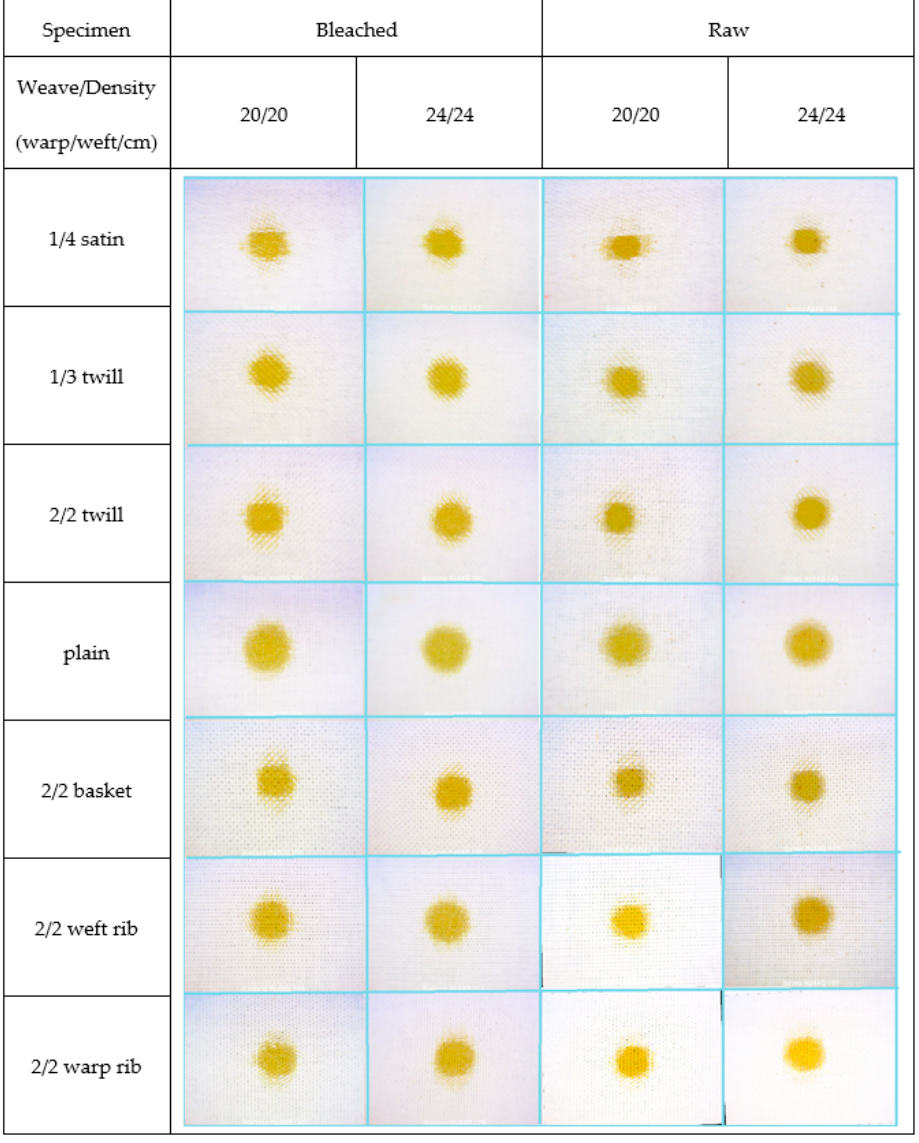
Figure 8. Images of raw and bleached specimens at the end of spreading of pumpkin oil droplets. The distribution along the channels extends in the direction of diagonal stripes at an angle of 45 ◦ to the warp